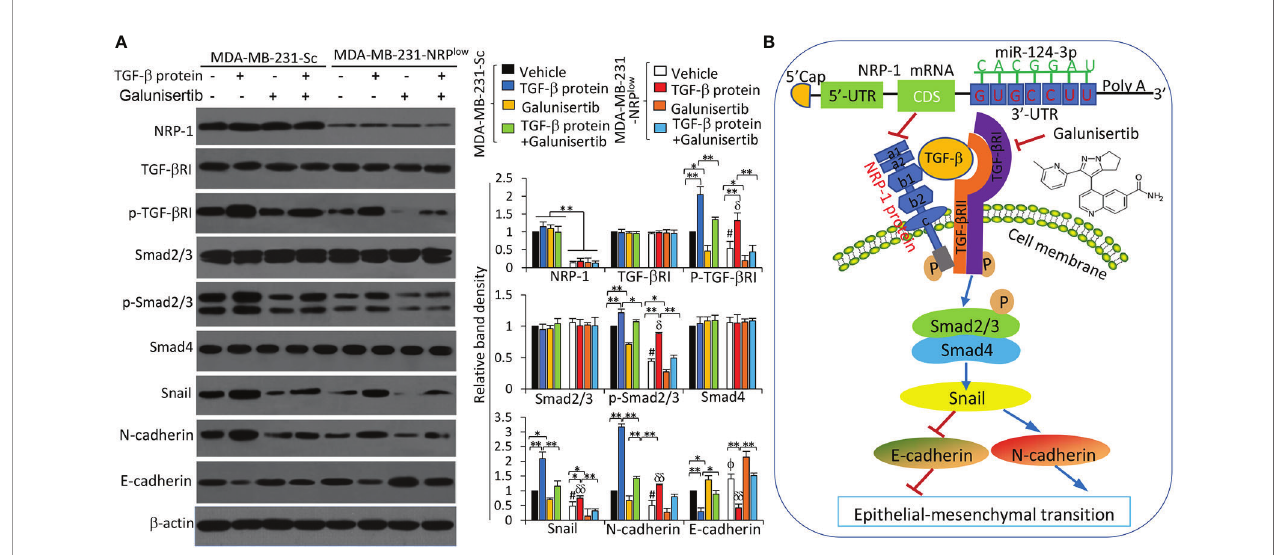
FIGURE 9 | The miR-124-3p/NRP-1 axis co-activates the TGF- b signaling pathway. (A) MDA-MB-231-Sc and MDA-MB-231-NRP low cells were treated with recombinant TGF- b protein (5 ng/ml), or galunisertib (10 m g/ml) or the combination for 24 h. Western blot analysis was used to detect the expression of proteins in cell lysates. Band density was measured and normalized to the band of each protein from vehicle-treated MDA-MB-231-Sc cells, which was set to 1. A one-way ANOVA with a Tukey post-hoc test was used for statistical analysis. “ *P < 0.05 ” and “ **P < 0.001 ” indicate a signi fi cant difference; “ f P < 0.05 ” indicates a signi fi cant increase, while “ # P < 0.05 ” , a signi fi cant reduction, from vehicle-treated MDA-MB-231-Sc cells; “ d P < 0.05 ” and “ dd P < 0.001 ” indicate a signi fi cant difference from TGF- b -treated MDA-MB-231-Sc cells. (B) A proposed diagram shows how the miR-124-3p/NRP-1 axis co-activates the TGF- b signaling pathway to regulate EMT- related molecules in TNBC cells. MiR-124-3p binds to the 3 ’ -UTR of NRP-1 mRNA and inhibits NRP-1 expression. The structure of NRP-1 protein contains 5 extracellular domains, a transmembrane domain and a short cytosolic tail. “ ! ” indicates promoting, or activating, while “ ⟘ “ , inhibiting or blocking. “ p ” indicates protein phosphorylation. NRP-1, neuropilin-1; CDS, coding sequence; TGF- b , transforming growth factor- b , TGF- b R, TGF- b receptor; UTR, untranslated